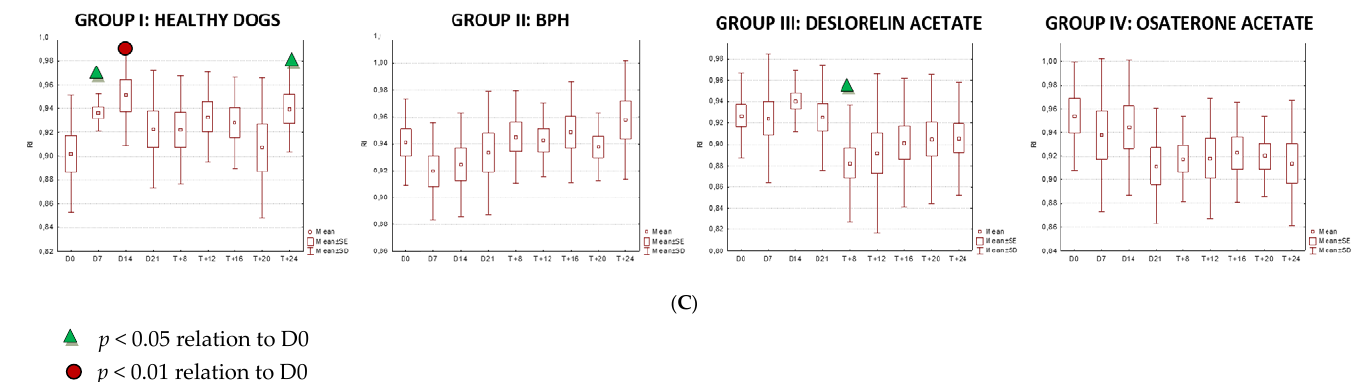
p < 0.05 relation to D0 p < 0.01 relation to D0 Figure 5. Changes of blood flow velocity (( A )—systolic peak velocity, SPV, cm / s; ( B )—mean velocity, Vmean, cm / s; ( C )—resistive index, RI) in the prostatic arteries compared to Day 0 (D0) values in the investigated groups of dogs during the 24 weeks of observation (mean, SD, SE).